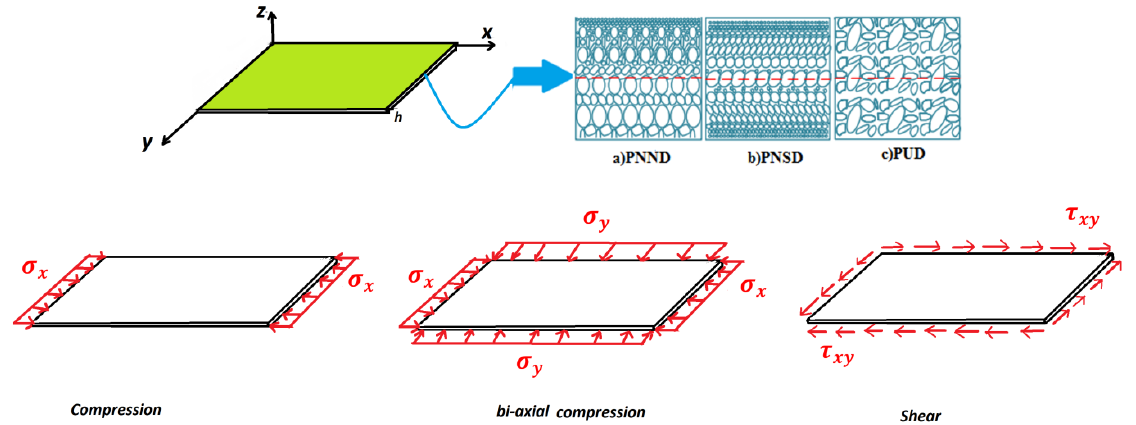
Figure 1. Geometrical scheme and loading conditions for a FG-saturated porous plate.